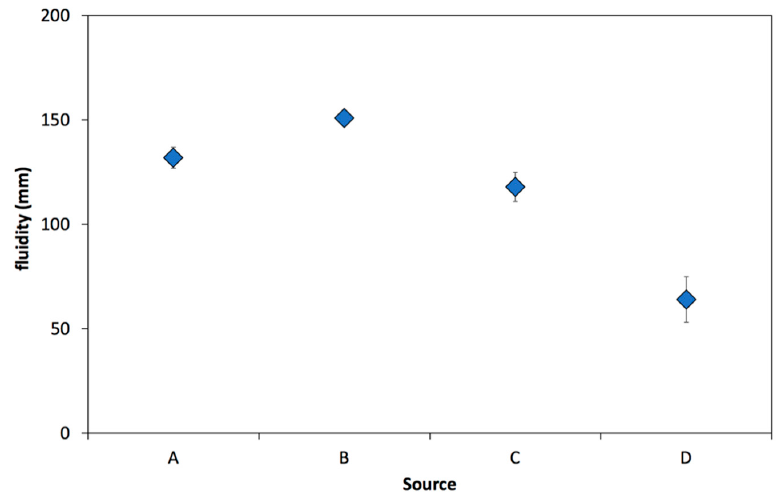
Figure 3. Change in fluidity length with source.